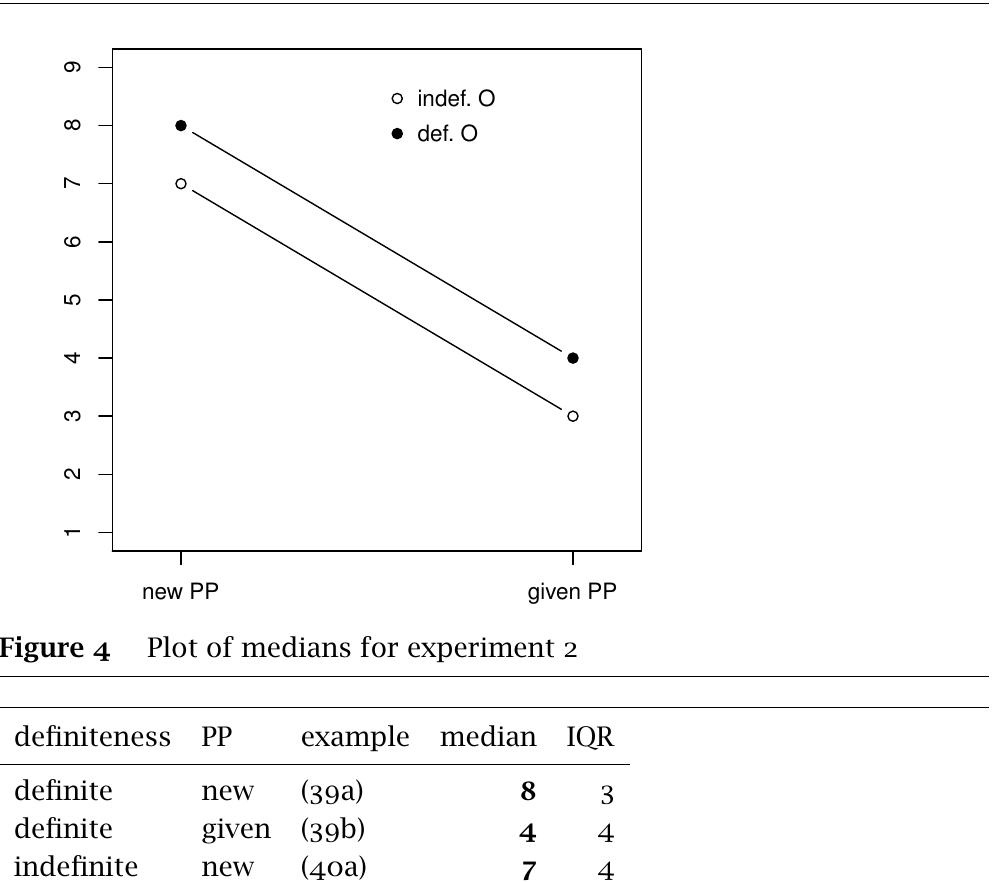
Summary of medians and interquartile ranges (IQR) for exp.